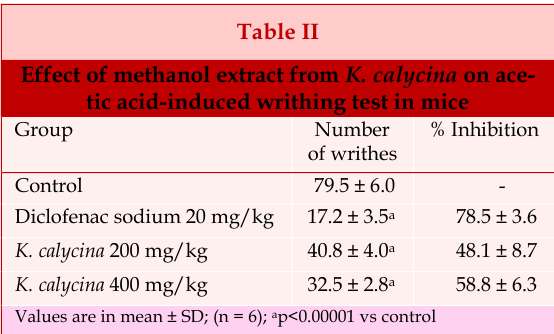
Effect of methanol extract from K. calycina on ace-